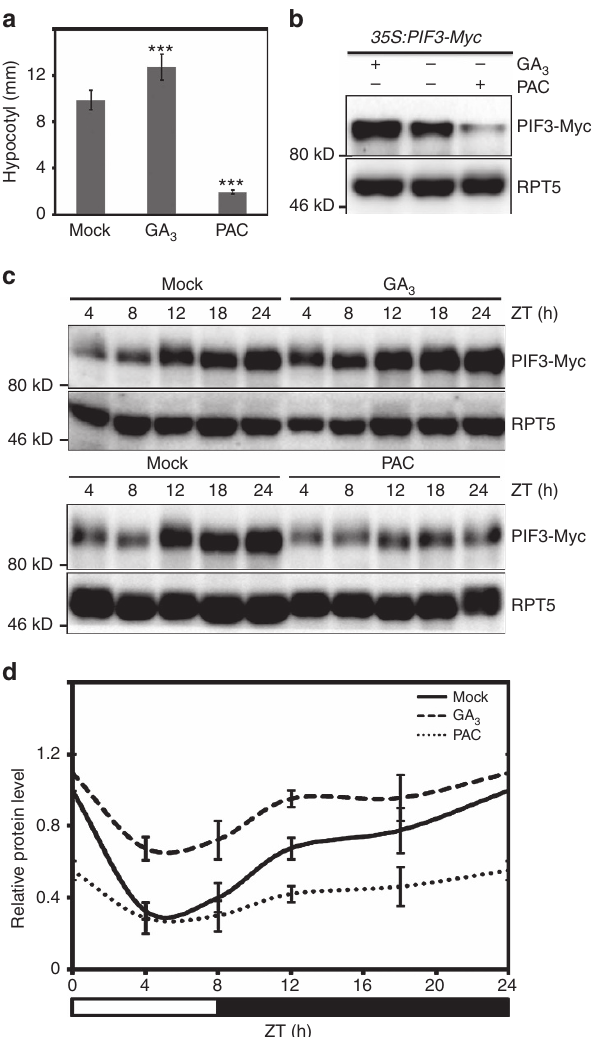
Figure 4 | DELLAs negatively regulate PIF3 protein abundance under continuous light and diurnal conditions. ( a ) Hypocotyl lengths of 4-day-old 35S:PIF3-Myc seedlings treated with GA 3 (10 m M) or PAC (0.5 m M) under continuous red light. Means ± s.d. were calculated from at least 30 seedlings. Statistical significance was determined using the Student’s t tests between the GA 3 or PAC treatment and Mock. *** P o 0.001. ( b ) PIF3-Myc protein levels of the seedlings shown in ( a ). Total proteins were analyzed by immunoblots using anti-Myc and anti-RPT5. RPT5 was used as a loading control. ( c ) Levels of PIF3-Myc proteins in seedlings grown under diurnal conditions. 35S:PIF3-Myc seedlings were grown on the medium without treatment, with GA 3 (10 m M), or with PAC (0.5 m M) under short-day condition (8h white light/16h darkness) for 5 days, and samples were collected at the indicated times. ( d ) The quantification of the western blot results from ( c ) using image J software. PIF3-Myc protein levels were normalized to RPT5 loading control. The value of Mock at ZT24 was set to be 1. Quantitative data are shown as means ± s.e.m., n ¼ 3.